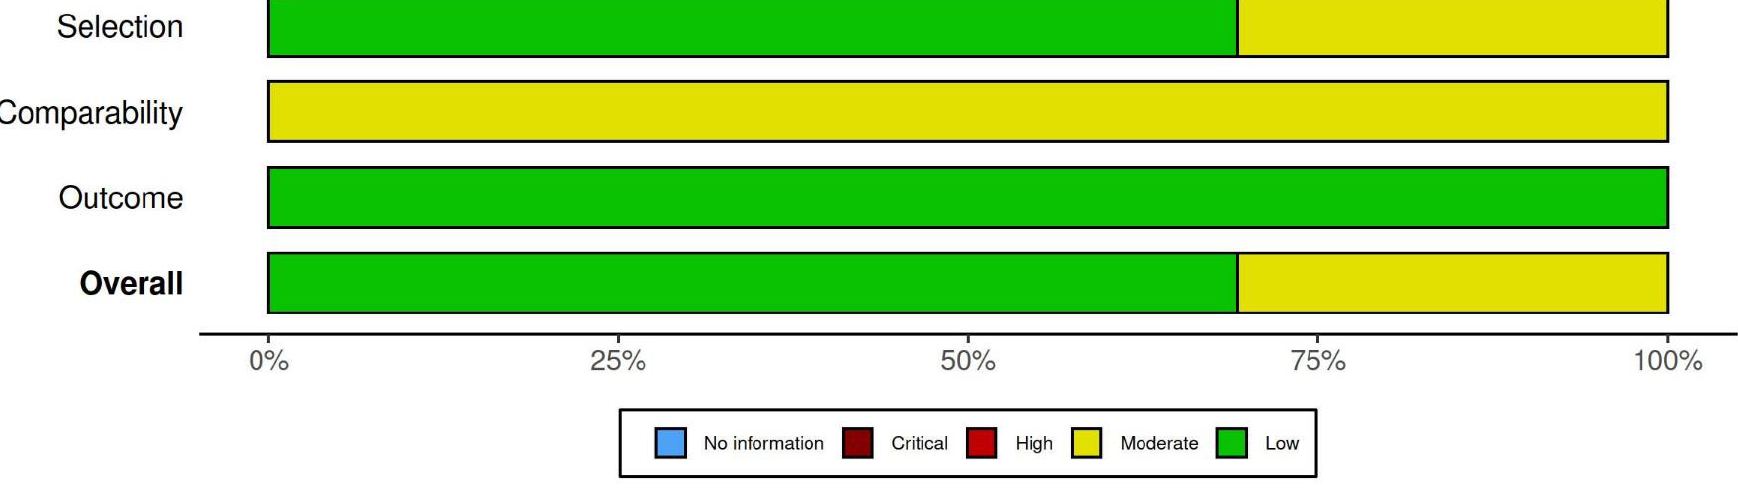
Figure 2. A summary plot of the risk of bias assessment.